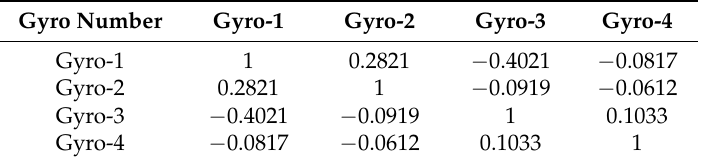
Table 3. Cross-correlation matrix of RRW noise for four-gyro array (Test 2). Table 4. Cross-correlation matrix of RRW noise for four-gyro array (Test 3). Gyro Number Gyro-1 Gyro-2